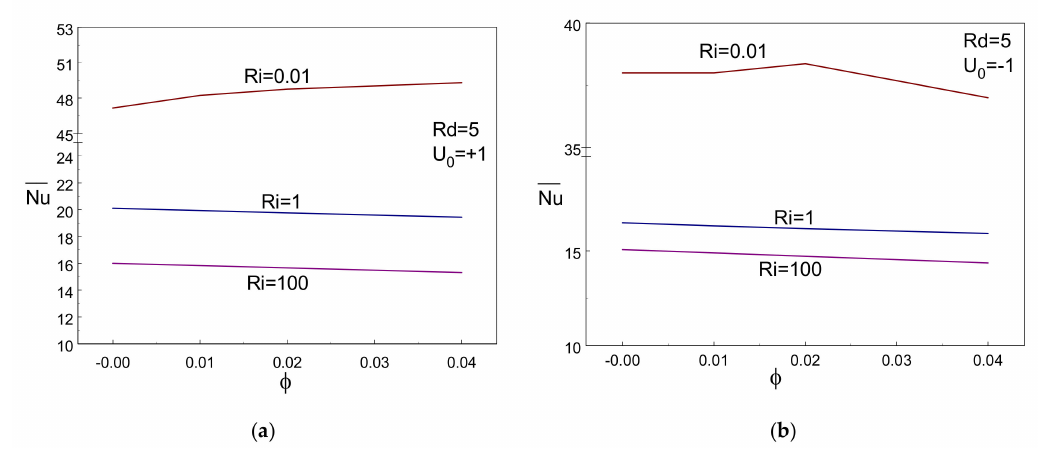
Figure 9. Averaged Nusselt number versus Φ for di ff erent Ri with Rd = 5. ( a ) Case 1; ( b ) Case